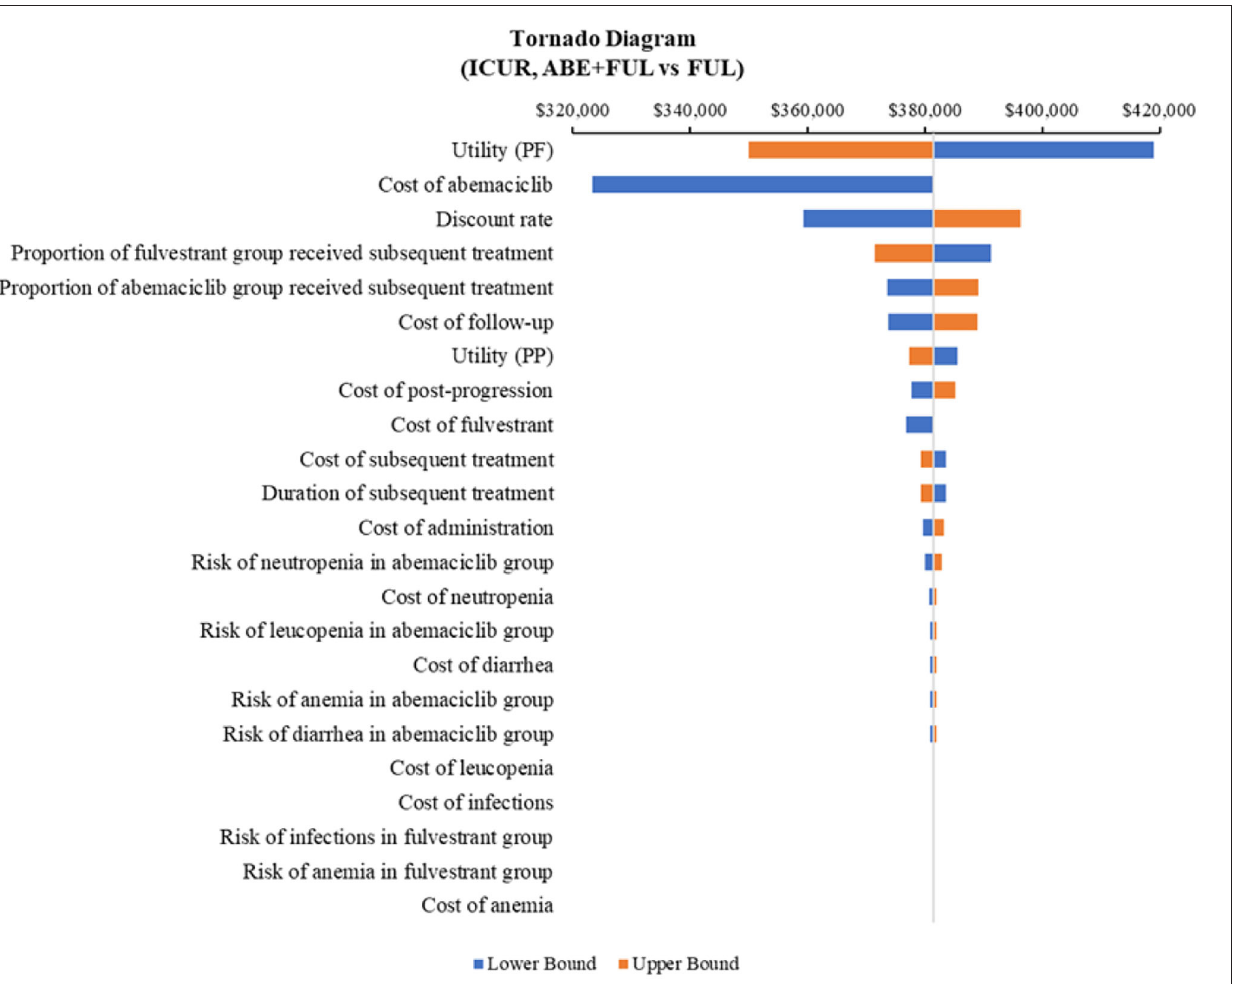
FIGURE 7 | Tornado diagram of the abemaciclib plus fulvestrant vs. fulvestrant monotherapy. ICUR, incremental cost-utility ratio; ABE, abemaciclib; FUL,